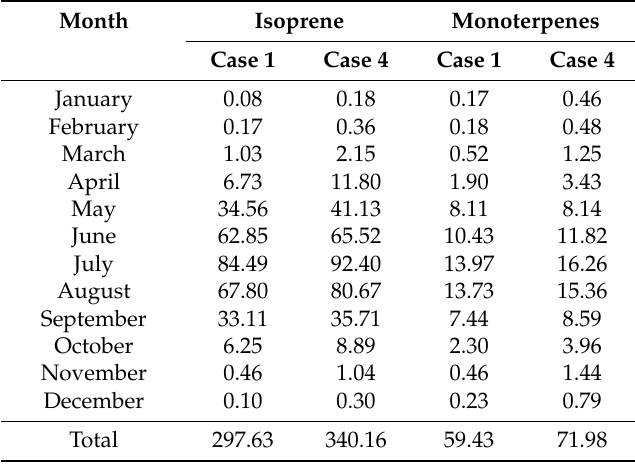
Table 10. Monthly biogenic emissions in North Korea (Gg /